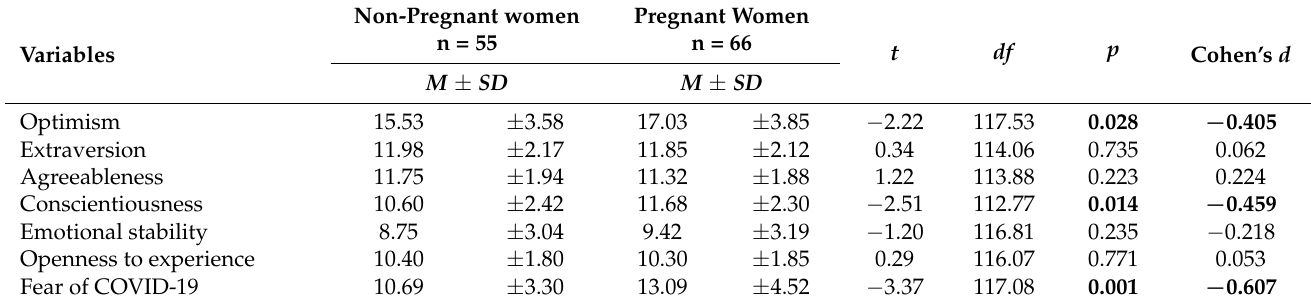
Table 2. Psychological traits assessed in pregnant and non-pregnant